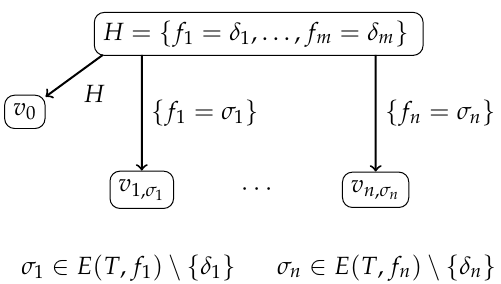
Figure 1. Prefix of decision tree Γ .